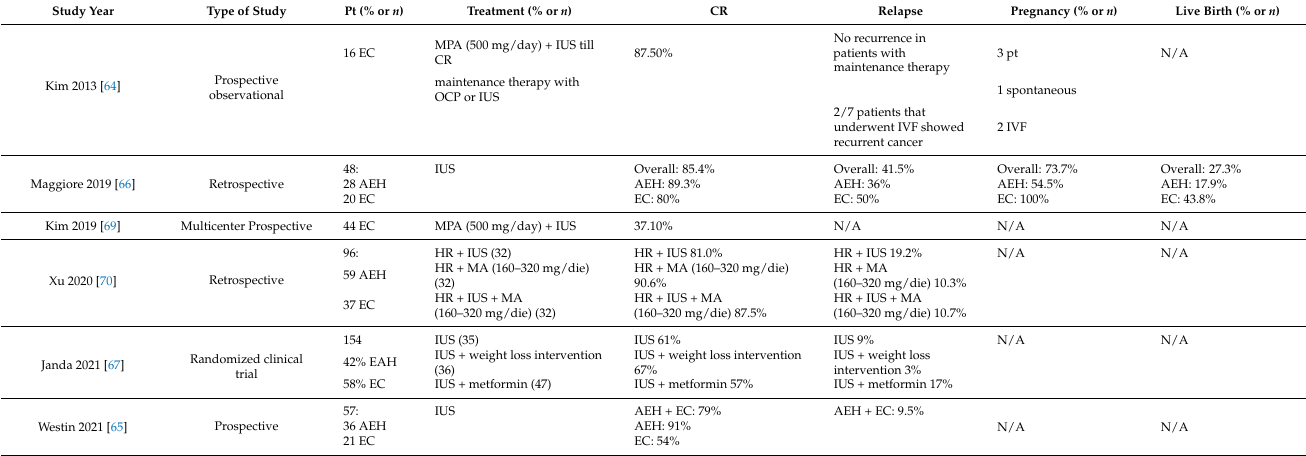
Table 2. Most recent studies on intrauterine systems for endometrial cancer and atypical endometrial